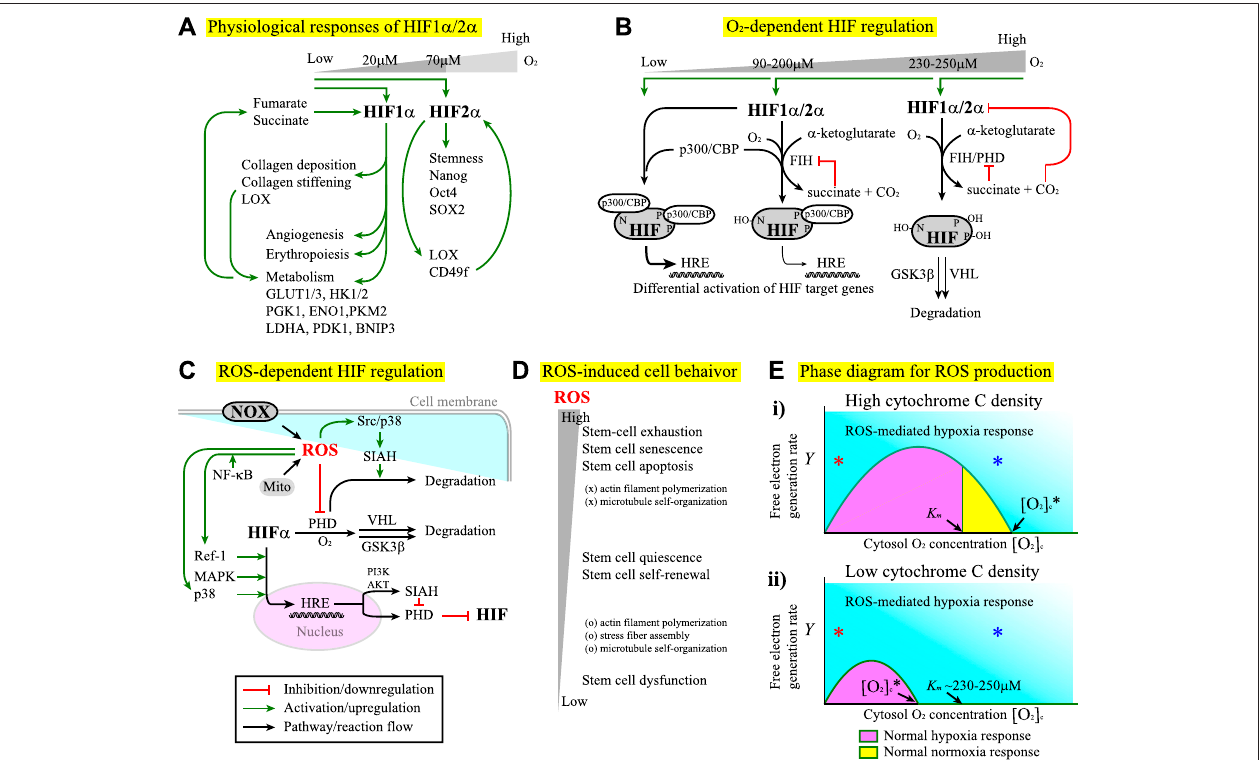
FIGURE 2 | (A) The differential responses of HIF-1 α and HIF-2 α to hypoxia conditions. See the main text for details. For all the fi gures hereafter, red lines indicate inhibitionor downregulation, green lines indicate activation or upregulation, blue linesindicate physical associationor recruitment, and black lines indicate the fl ow of the pathways, cascades, or reaction. (B) The factor inhibiting HIF (FIH) and prolyl hydroxylase domain-containing proteins (PHD) regulate HIF-1 α and HIF-2 α stability and transcriptional activity in an O 2 concentration-dependent manner. See Module Box II for details. (C) ROS produced by the NOX and/or the mitochondria (Mito) exhibit both positive and negative effects on the regulation of HIF- α subunits. See Module Box III for details. (D) Stem cells exhibit differential phenotypical behavior and cytoskeletal dynamics in response to the changes in ROS concentrations. (E) The phase diagrams for the separation of ROS-mediated hypoxia responses (cyan) from normalhypoxia(pink)and/ornormoxia(yellow)responsesat (i) highand (ii) lowcytochromeCdensitiescorrespondingtothehighandlowcriticaloxygenconcentrations ([O 2 ] c *) for the onset of ROS-mediated hypoxia responses, respectively. See Math Box I for details. K m is the K m value of PHD for [O 2 ] association (~230 – 250 μ M (Fong and Takeda, 2008)). The x -axis indicates the cytoplasmic oxygen concentrations (in arbitrary units). The y -axis indicates the free-electron generation rate in the electron transfer chain (in arbitrary units). Red * and blue * indicate that ROS-mediated hypoxia responses can occur at low and high (even above K m ) oxygen concentrations, respectively, as long as the free electron generation rate y is suf fi ciently